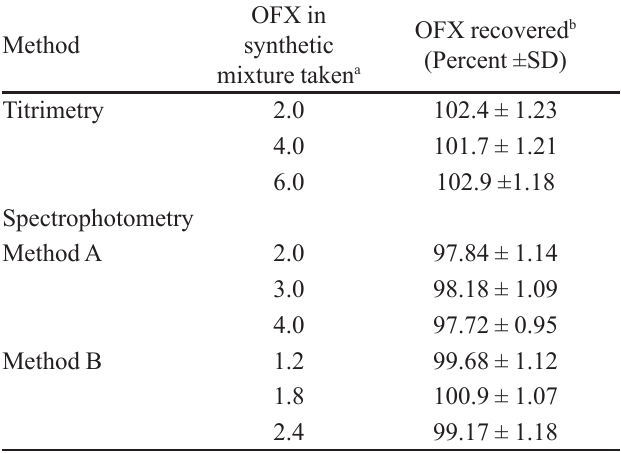
TABLE IV - Recovery of drug from synthetic mixture